Question: Condense the content of this figure into a single sentence.
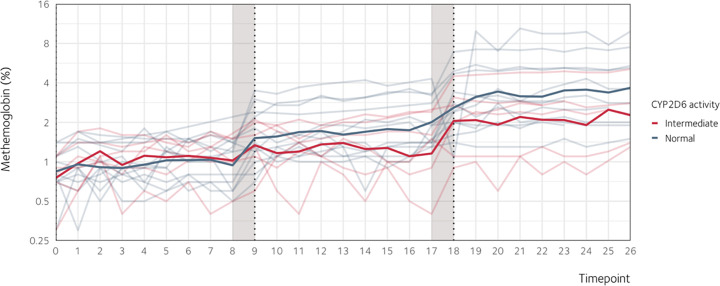
Answer: Temporal dynamics of blood methemoglobin levels. Methemoglobin levels were measured on Day 0 (day of enrollment, time points 0–8), Day 1 (time points 9–17), and Day 2 (time points 18–26); stratified by genotype-predicted CYP2D6 phenotype. Each transparent red or blue line corresponds to an individual. Solid red and blue lines correspond to the average at each time point. The time interval between consecutive timepoints is approximately 30 min, except for those shaded in gray, which represent several hours leading to the next day’s measurements (intervals between 8–9 and 17–18). Time points 0, 9, and 18 (dotted vertical lines) correspond to the daily pre-dose measurements. The vertical axis is shown on a logarithmic scale.